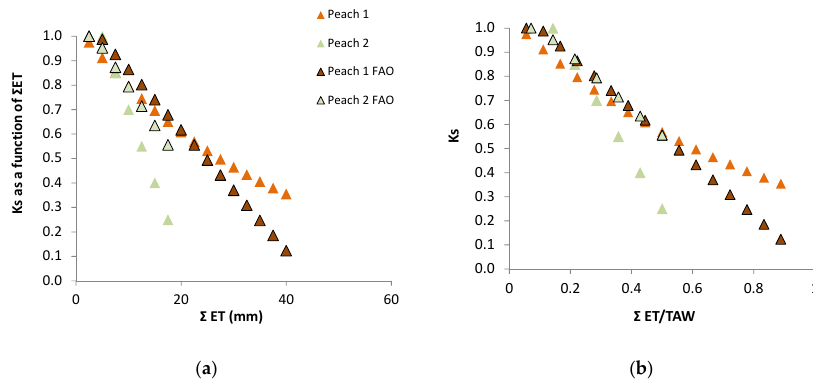
Figure 10. Stress functions based on experimental data (Figure 3) and obtained with Equation (2) for ( a ) cumulated ET ( Σ ET) and ( b ) Σ ET divided by total available water in the root zone (TAW), for the two experimental situations where it was possible to estimate TAW reasonably well. Symbols are the same in both figures.